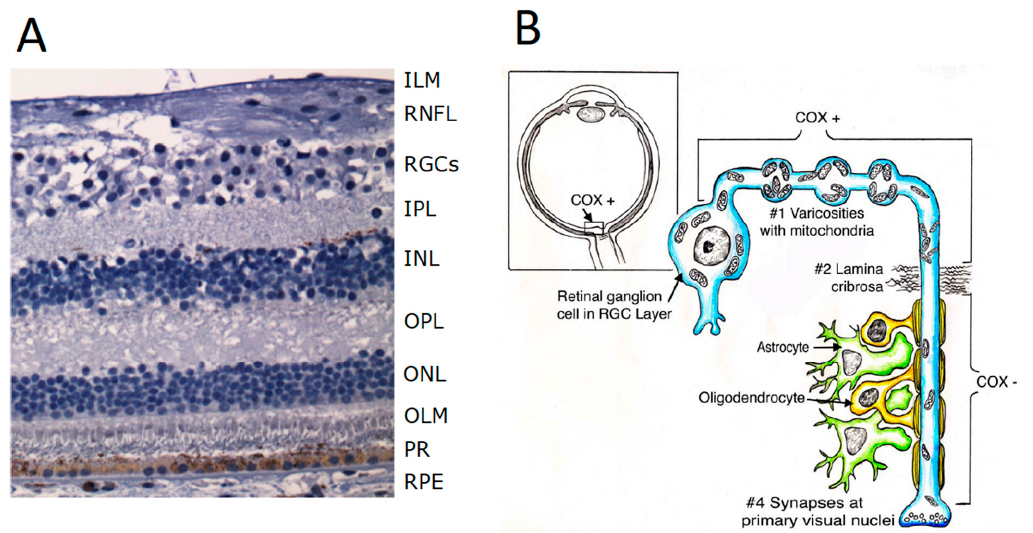
Figure 2. Anatomy of the retina and its connections. ( A ) A section of normal retina. ILM: inner limiting membrane; RNFL: retinal nerve fibres layer; RGCs: retinal ganglion cells; IPL: inner plexiform layer; INKL: inner neuronal layer; OPL: outer plexiform layer; ONL: outer neuronal layer; OLM: outer limiting membrane; PR: photoreceptors (inner segments); RPE: retinal pigmentary epithelium (modified from Maresca A, Carelli V, 2021 [18]). ( B ) The structure of the eyeball is outlined in the upper left inset and a retinal ganglion cell is outlined with the part of the axon (proximal to the lamina cribrosa, unmyelinated), as well as the initial part of the axon after the emersion from the lamina cribrosa, where it is myelinated by oligodendrocytes of the optic nerve. Notice the high number of mitochondria in the cell body and unmyelinated portion of the axon, often organized in mitochondrial “varicosities” compared with the few mitochondria present in the Ranvier nodes in the myelinated part of the axon (modified from Carelli V et al. 2004 [19]).